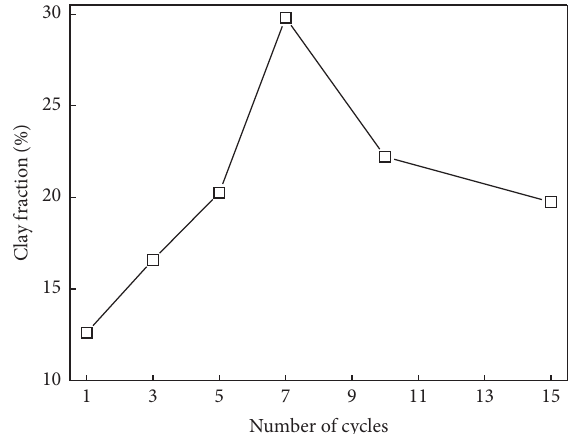
Figure 3: Relationships between the clay fraction and the number of drying-wetting cycles.